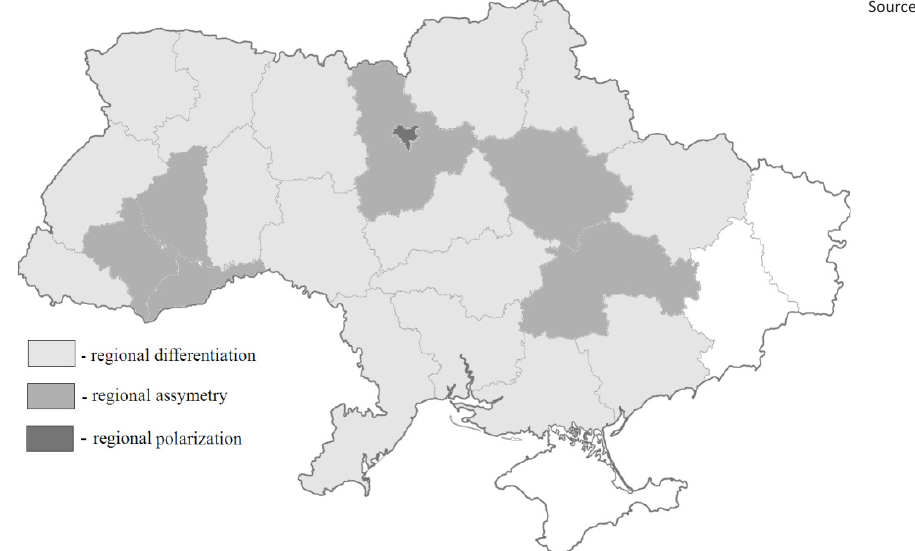
Figure 1. Regional disparities in Ukraine in 2010